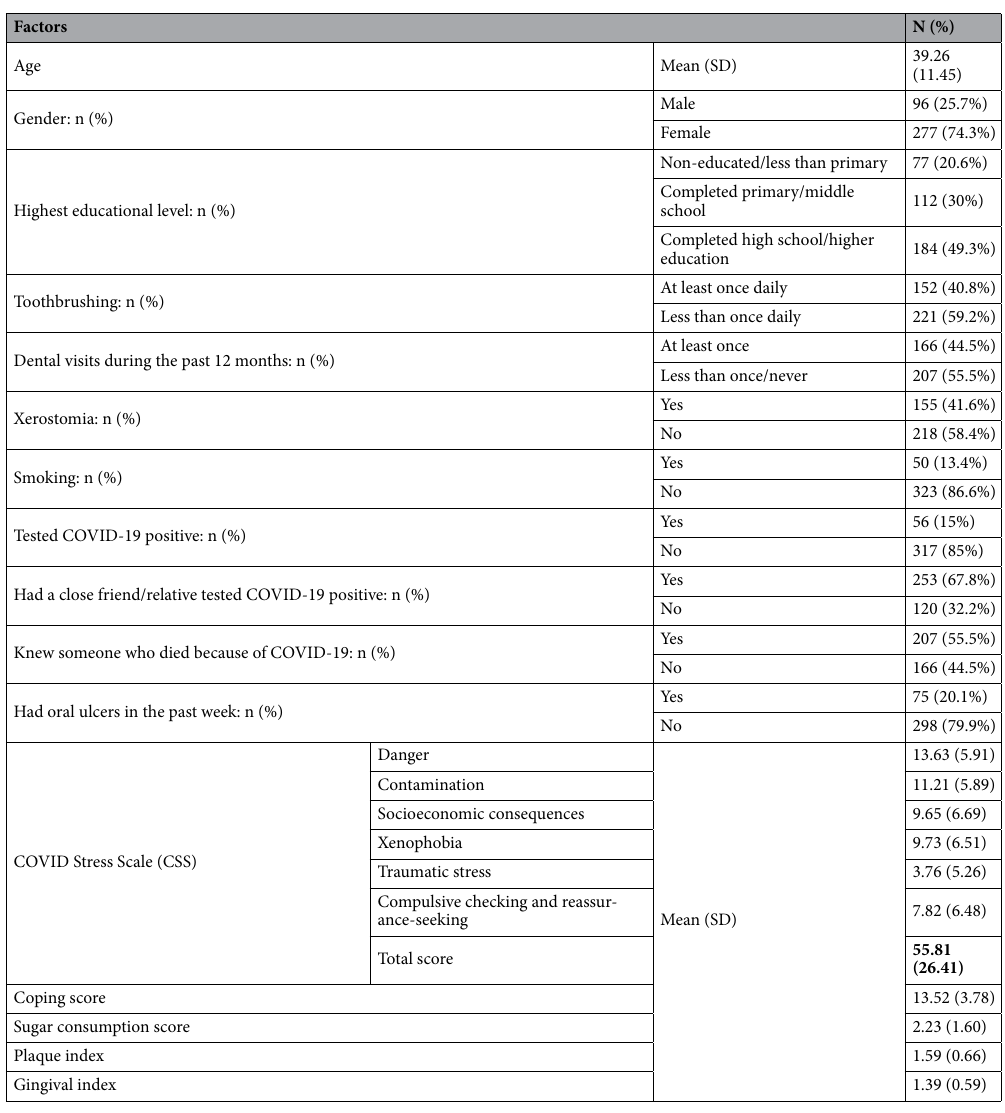
Table 1. Sample description (n = 373). SD Standard